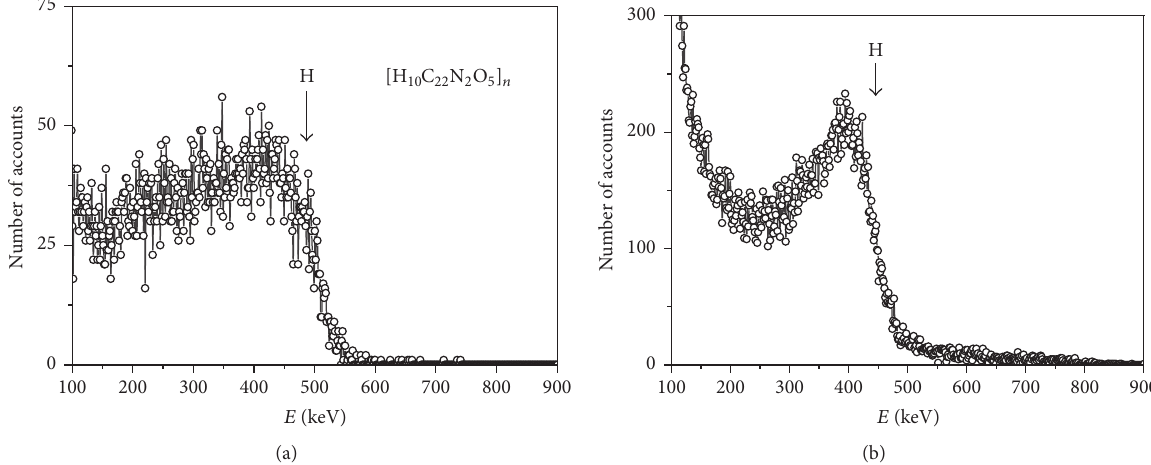
Figure 7: Spectra of knocked out hydrogen nuclei obtained for (a) [ H 10 C 22 N 2 O 5 ] 𝑛 and (b) VN 𝑥 -H 𝑦